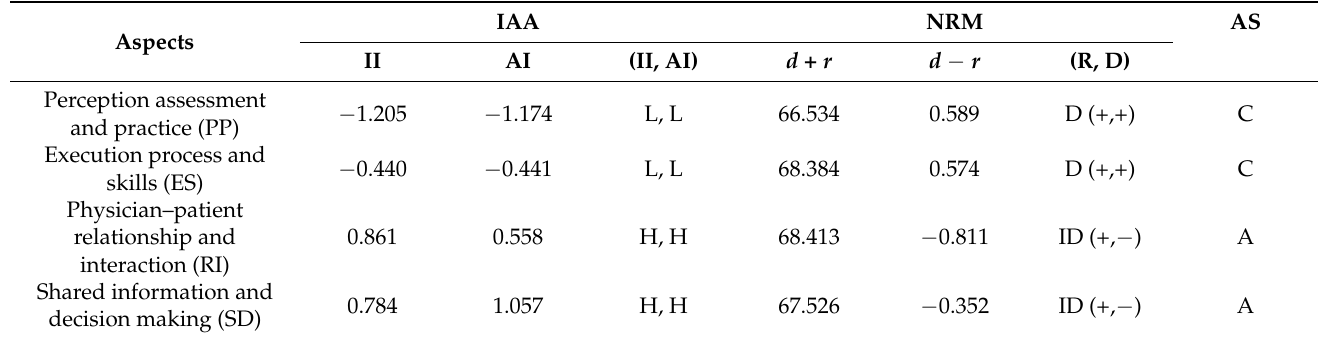
Table 10. The adoption strategy of SDM competency development for PGYs.